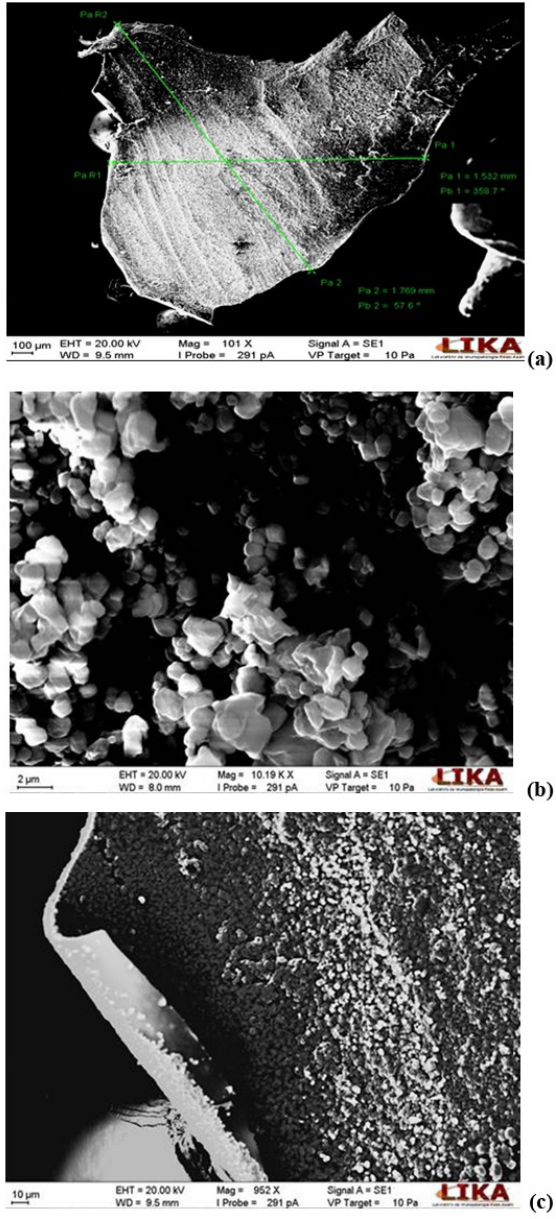
Figure 3 - SEM pictures of alginate/gelatin beads prepared with 1 % w/v of alginate and 0.1 % w/v of gelatin. (a) External aspect of the bead. Magnification of x101; (b) and (c) Internal aspect of the bead. Magnification of x10.19 K and x952, respectively.